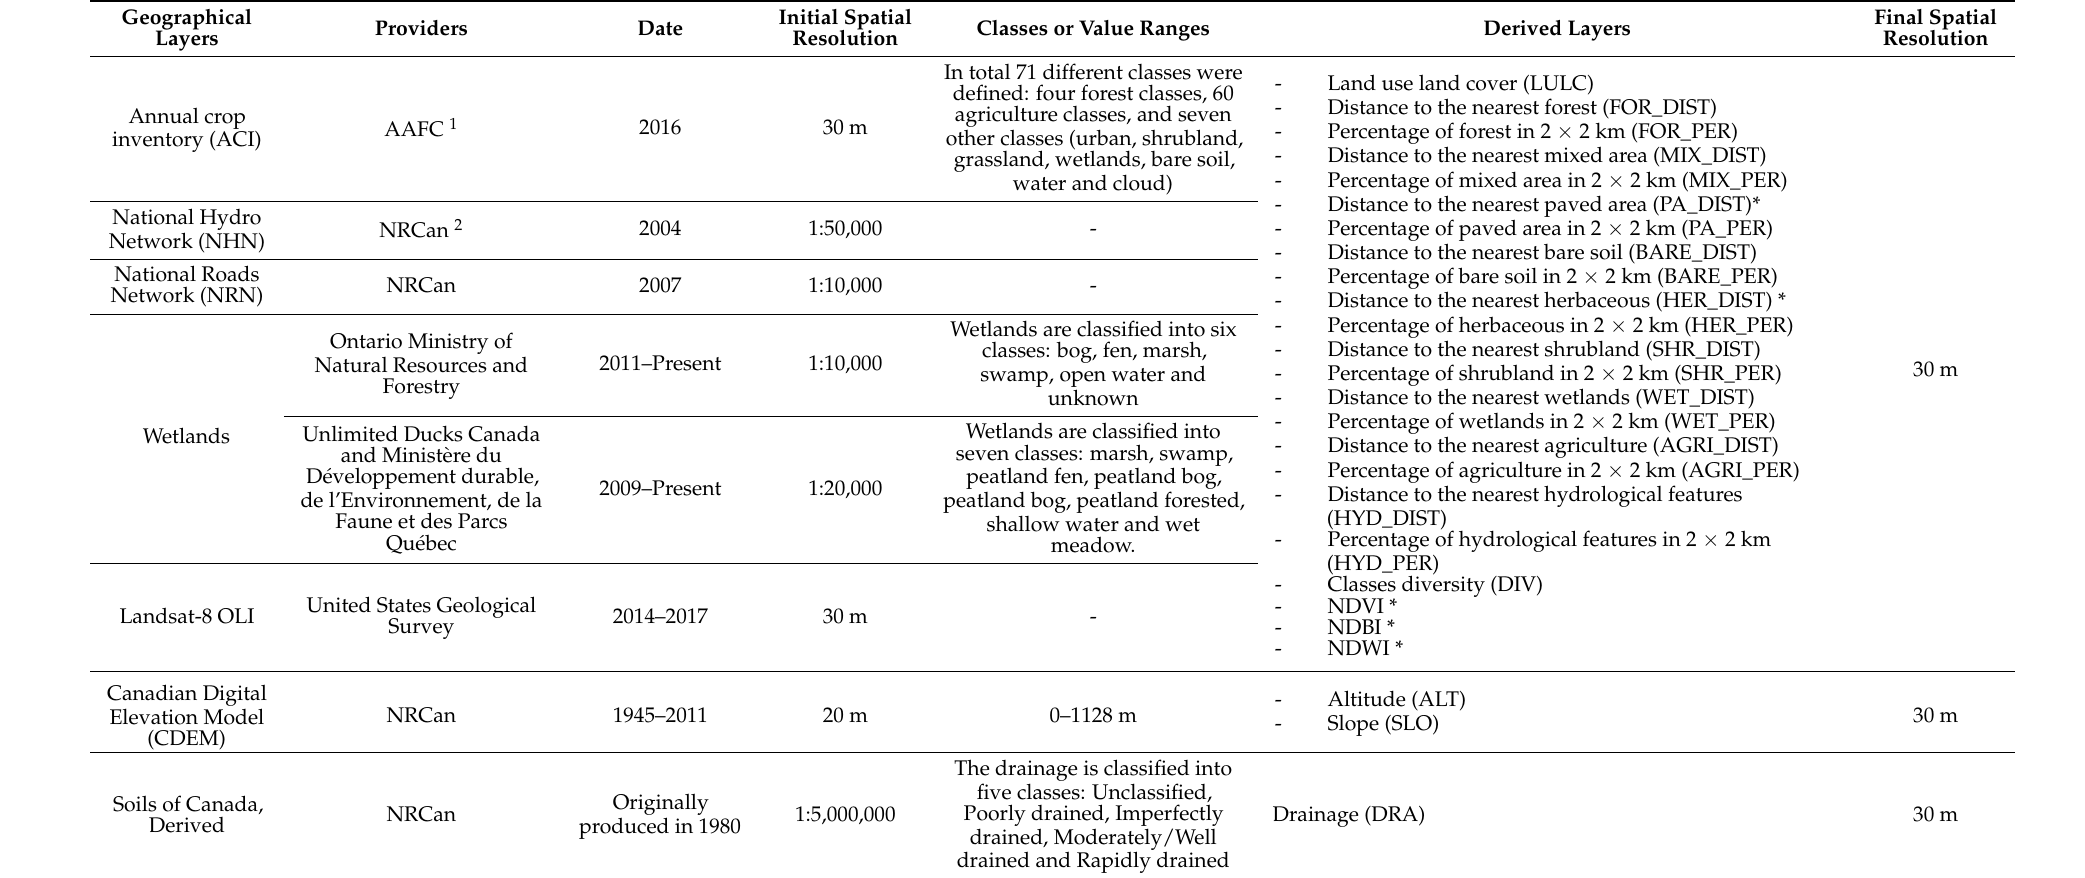
Table A2. Environmental data. Derived layers with an asterisk were not used to build the